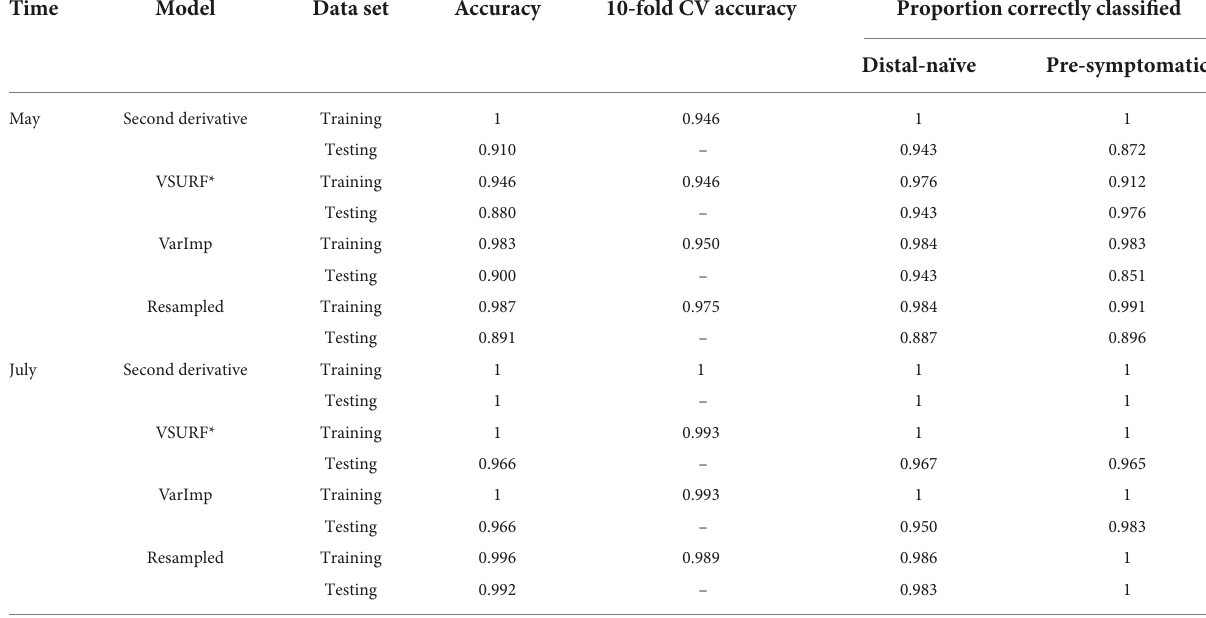
TABLE 1 Accuracies of the four distinct support vector machine (SVM) models used to classify leaf near-infrared (NIR) spectra based on tree symptom type for the May and July datasets.